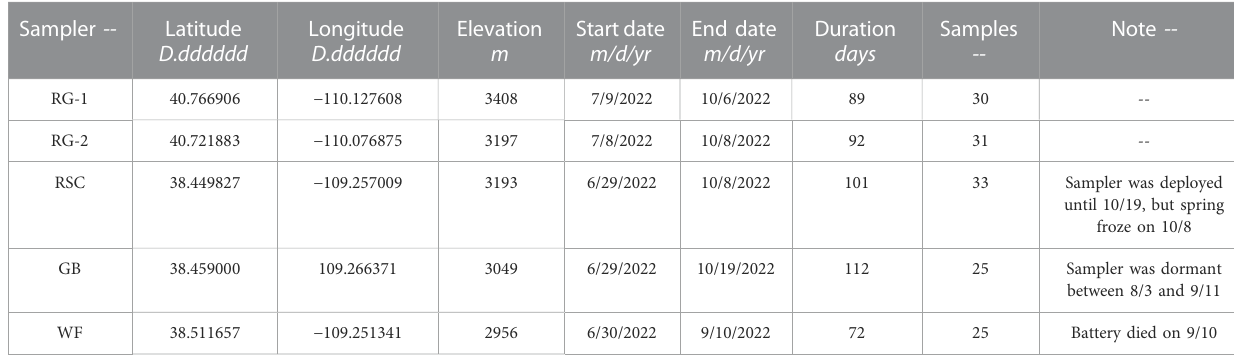
TABLE 1 Sampler locations and deployment